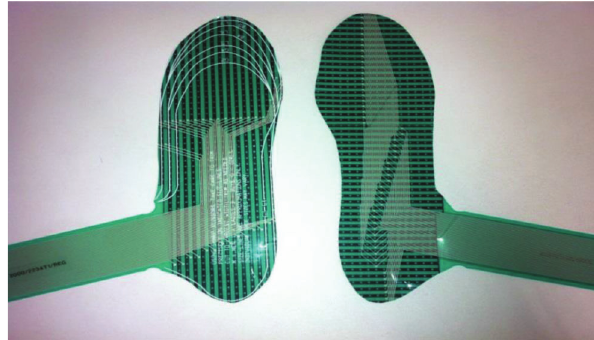
Figure 2 - Insoles. Each insole was 0.18 mm thick and had 960 sensors that were sensitive to mechanical strain and were evenly distributed every five millimetres as a screen over the entire surface of the